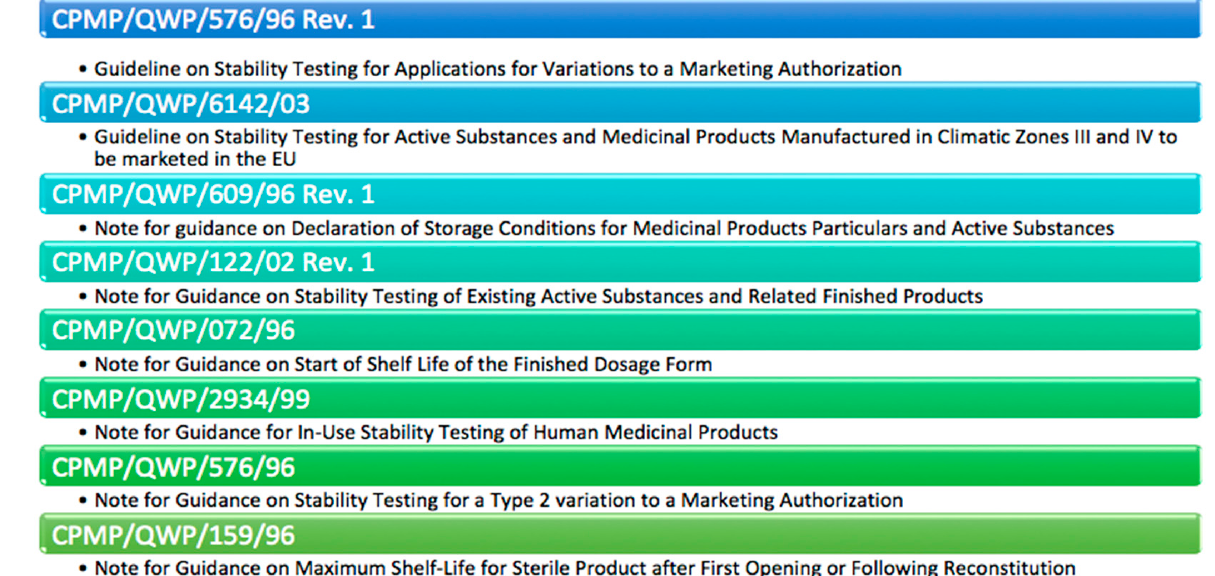
Figure 1. ICH codes and titles.